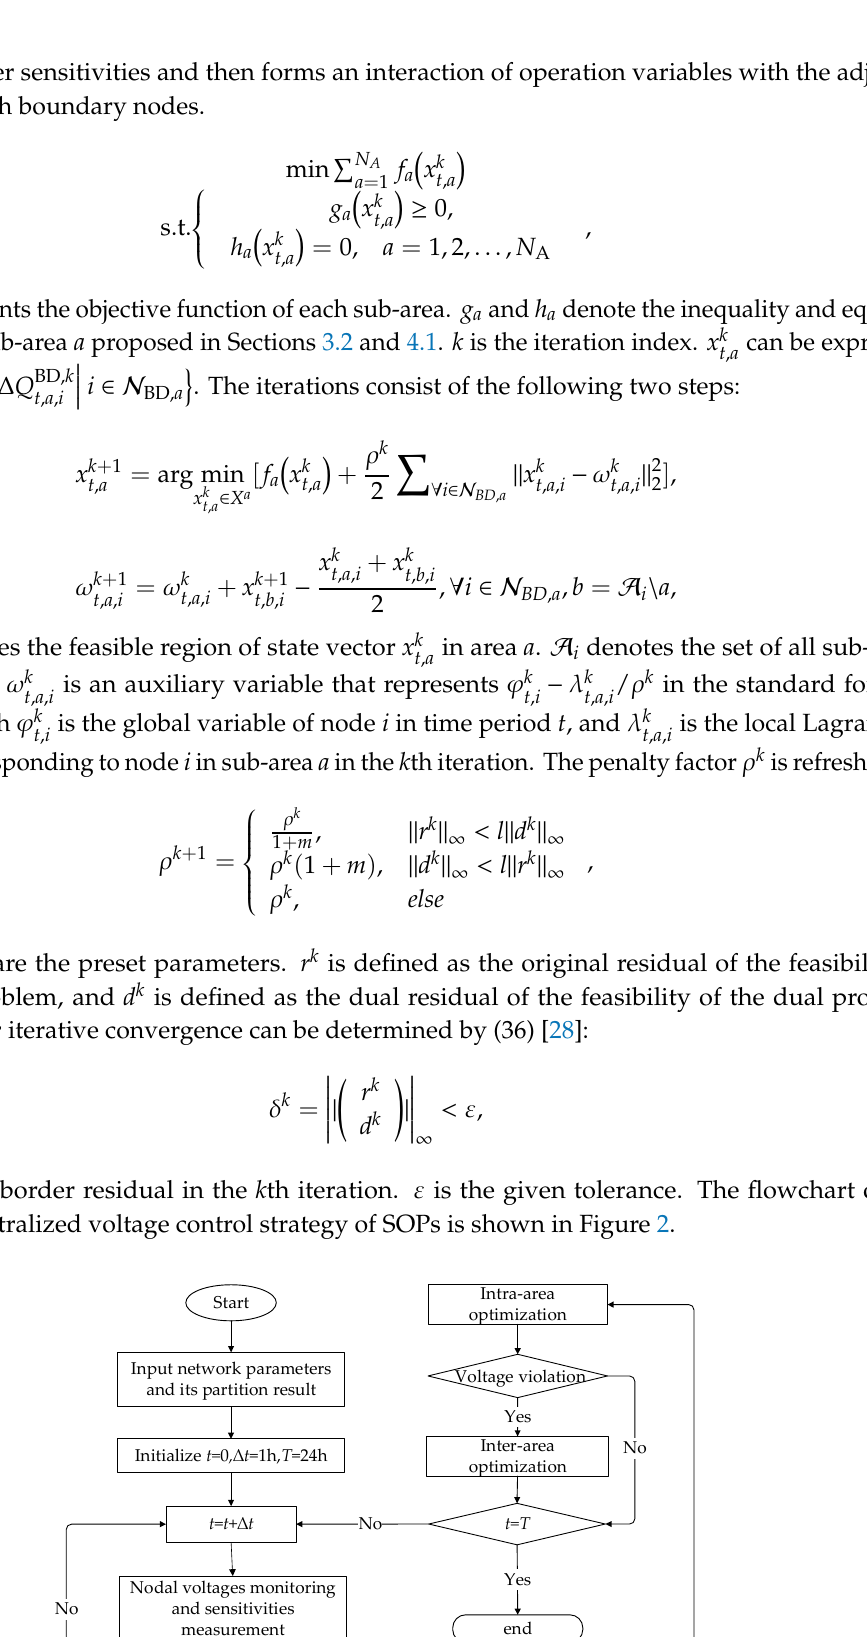
Figure 3. Diagram of the modified IEEE 33-node system. Table 1. Detailed installation parameters of DGs. Parameters